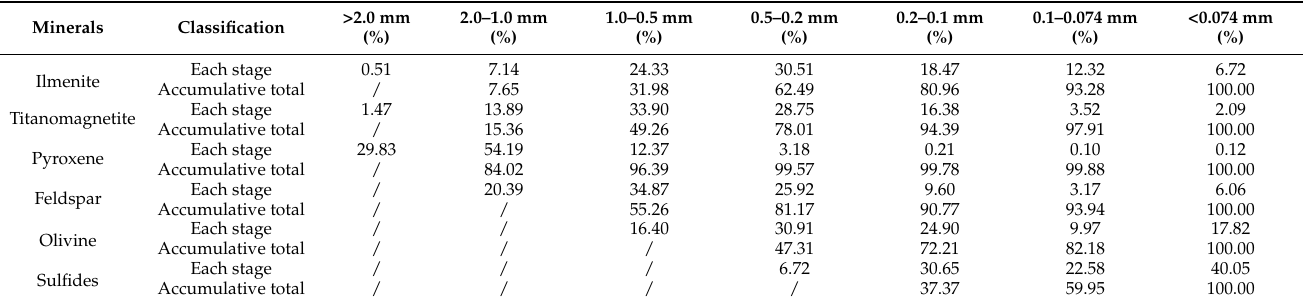
Table 9. Particle size distribution of the main minerals present in the